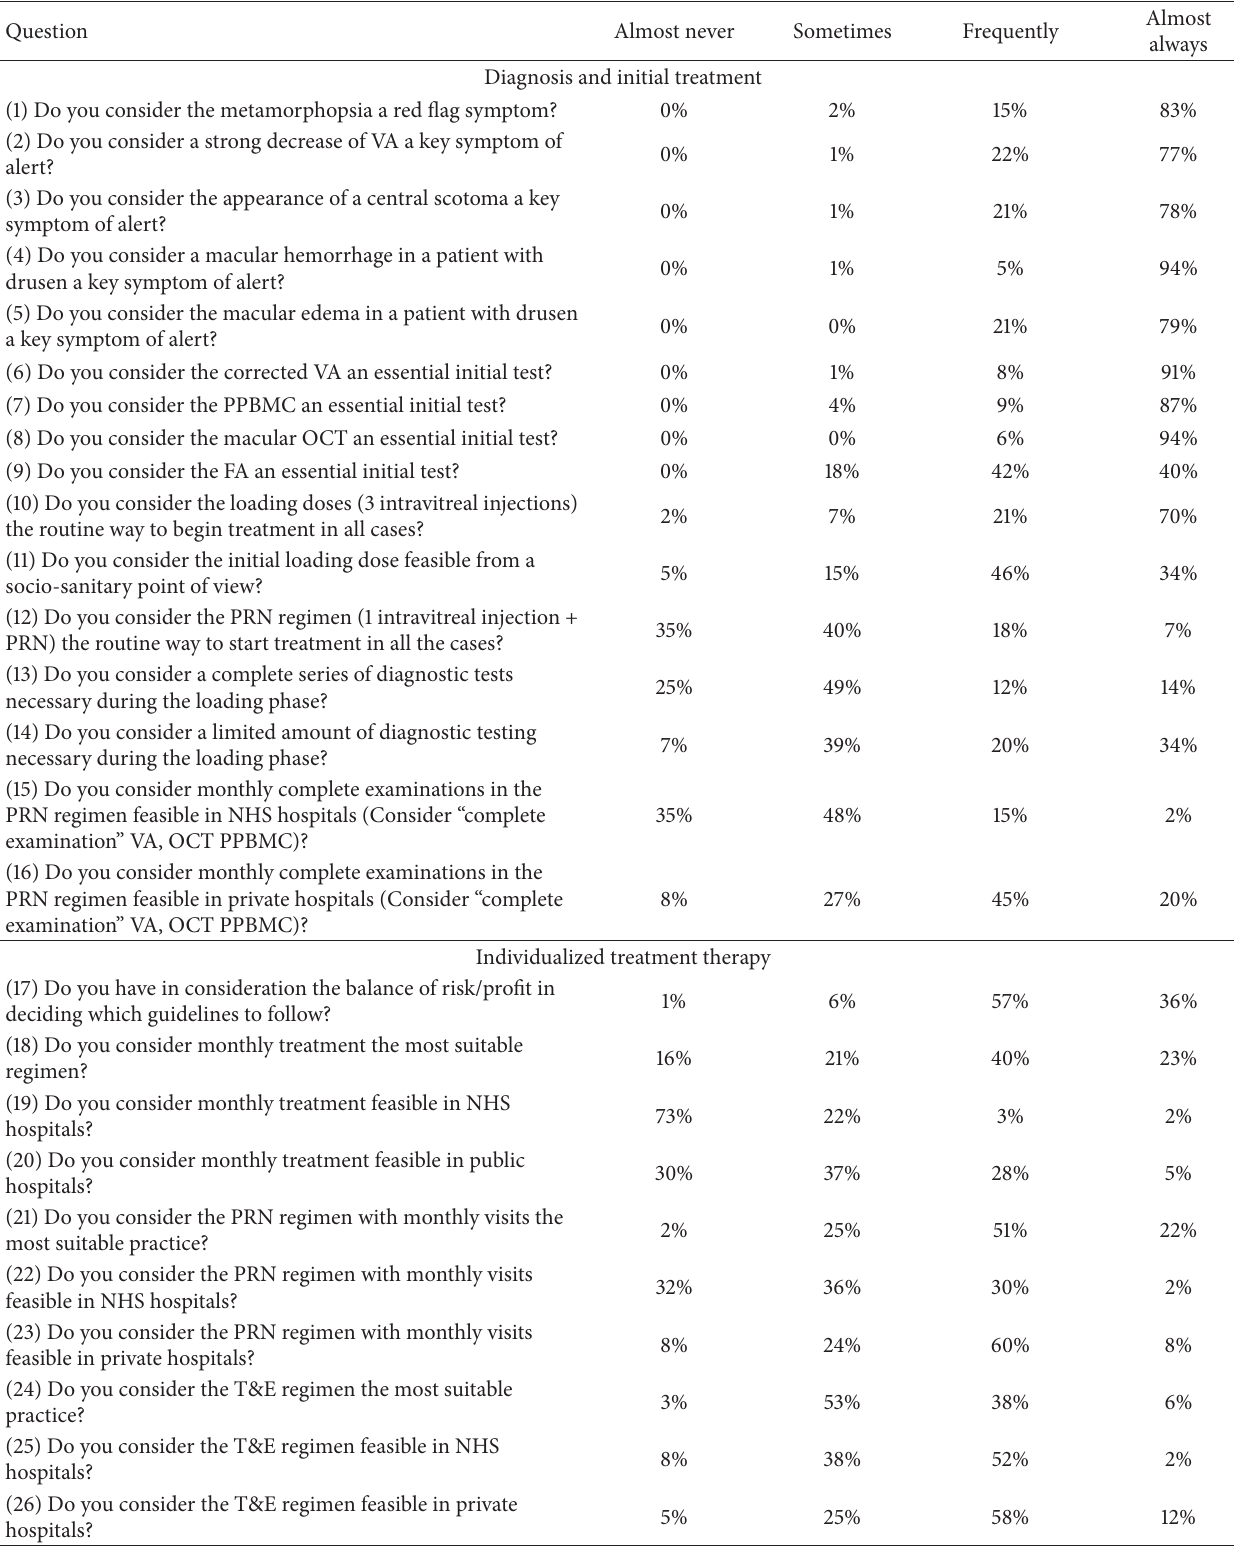
Table 1: Final answers for the second Delphi round